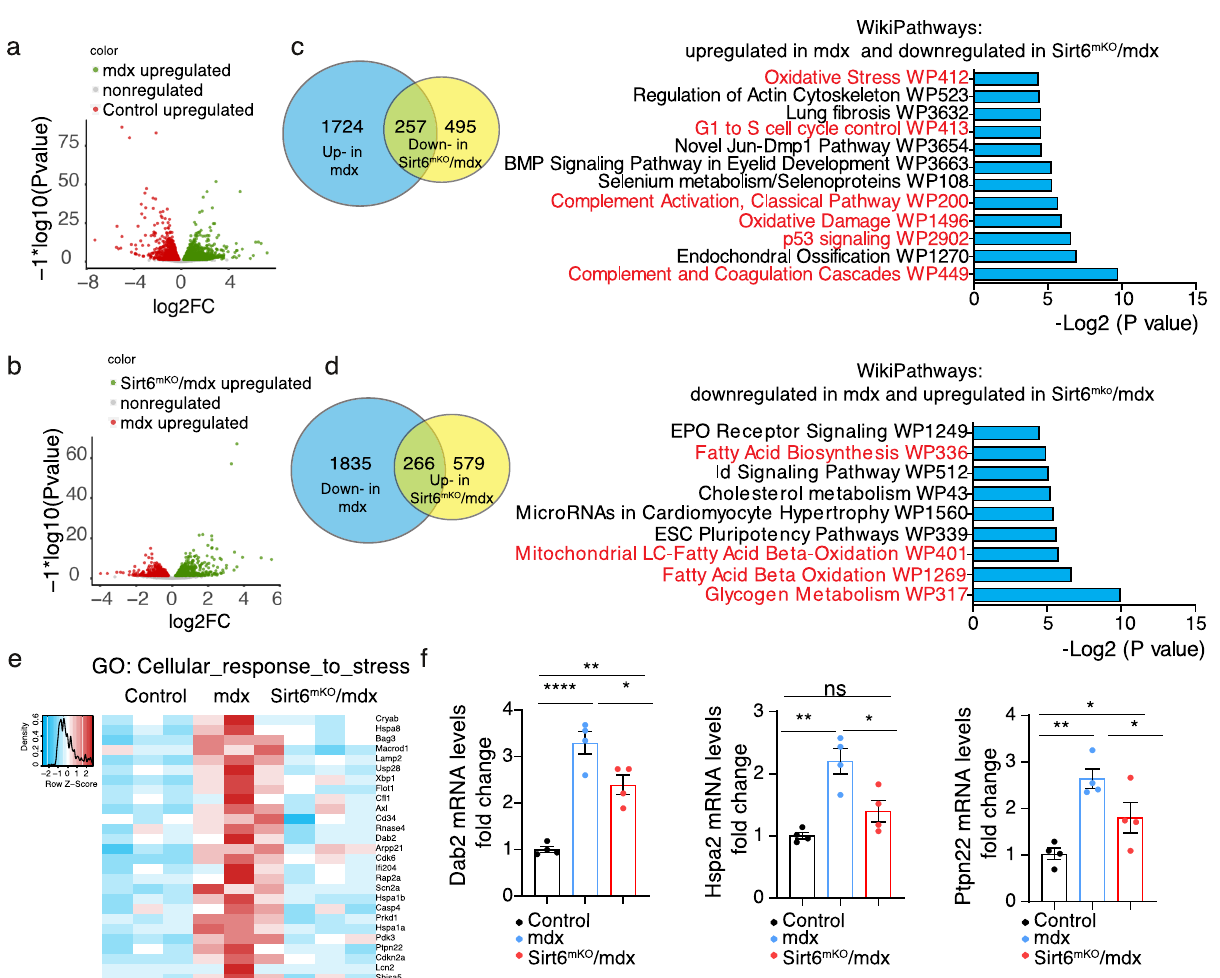
Fig. 4 Loss of Sirt6 partially normalizes aberrant expression patterns in dystrophic mdx muscles. a Volcano plot of differentially expressed genes in mdx compared to control muscles. Benjamini-Hochberg test, two-sided. b Volcano plot of differentially expressed genes in mdx compared to Sirt6 mKO /mdx muscles. Benjamini-Hochberg test, two-sided. c Venn diagram of overlapping upregulated genes in mdx muscle compared to control muscle and downregulated genes in Sirt6 mKO /mdx muscle compared to mdx muscles based on RNA-seq. In total, 257 overlapping genes were categorized by Wikipathways analysis. Fisher ’ s exact test, two-sided. d Venn diagram of overlapping downregulated genes in mdx compared to control muscle and upregulated genes in Sirt6 mKO /mdx muscle compared to mdx muscle based on RNA-seq. In total, 266 overlapping genes were categorized by Wikipathways analysis. Fisher ’ s exact test, two-sided. e Heat map of expression of genes involved in cellular stress responses in control, mdx and Sirt6 mKO /mdx muscle ( n = 3 for each group). f RT-qPCR analysis of expression of indicated genes involved in cellular stress responses in control, mdx and Sirt6 mKO /mdx muscles. m36b4 was used as reference gene (one-way ANOVA with Bonferroni multiple comparisons test: Dab2: * p = 0.0235, ** p = 0.0017; **** p <0.0001; Hspa2: ns not signi fi cant, * p = 0.0164, ** p = 0.0012; Ptpn22: ** p = 0.009, * p = 0.0316, * p = 0.0430; n = 4 for each group). Twelve to 16 weeks old male mice were used. Data are presented as mean±SEM. Source data are provided in the Source Data fi